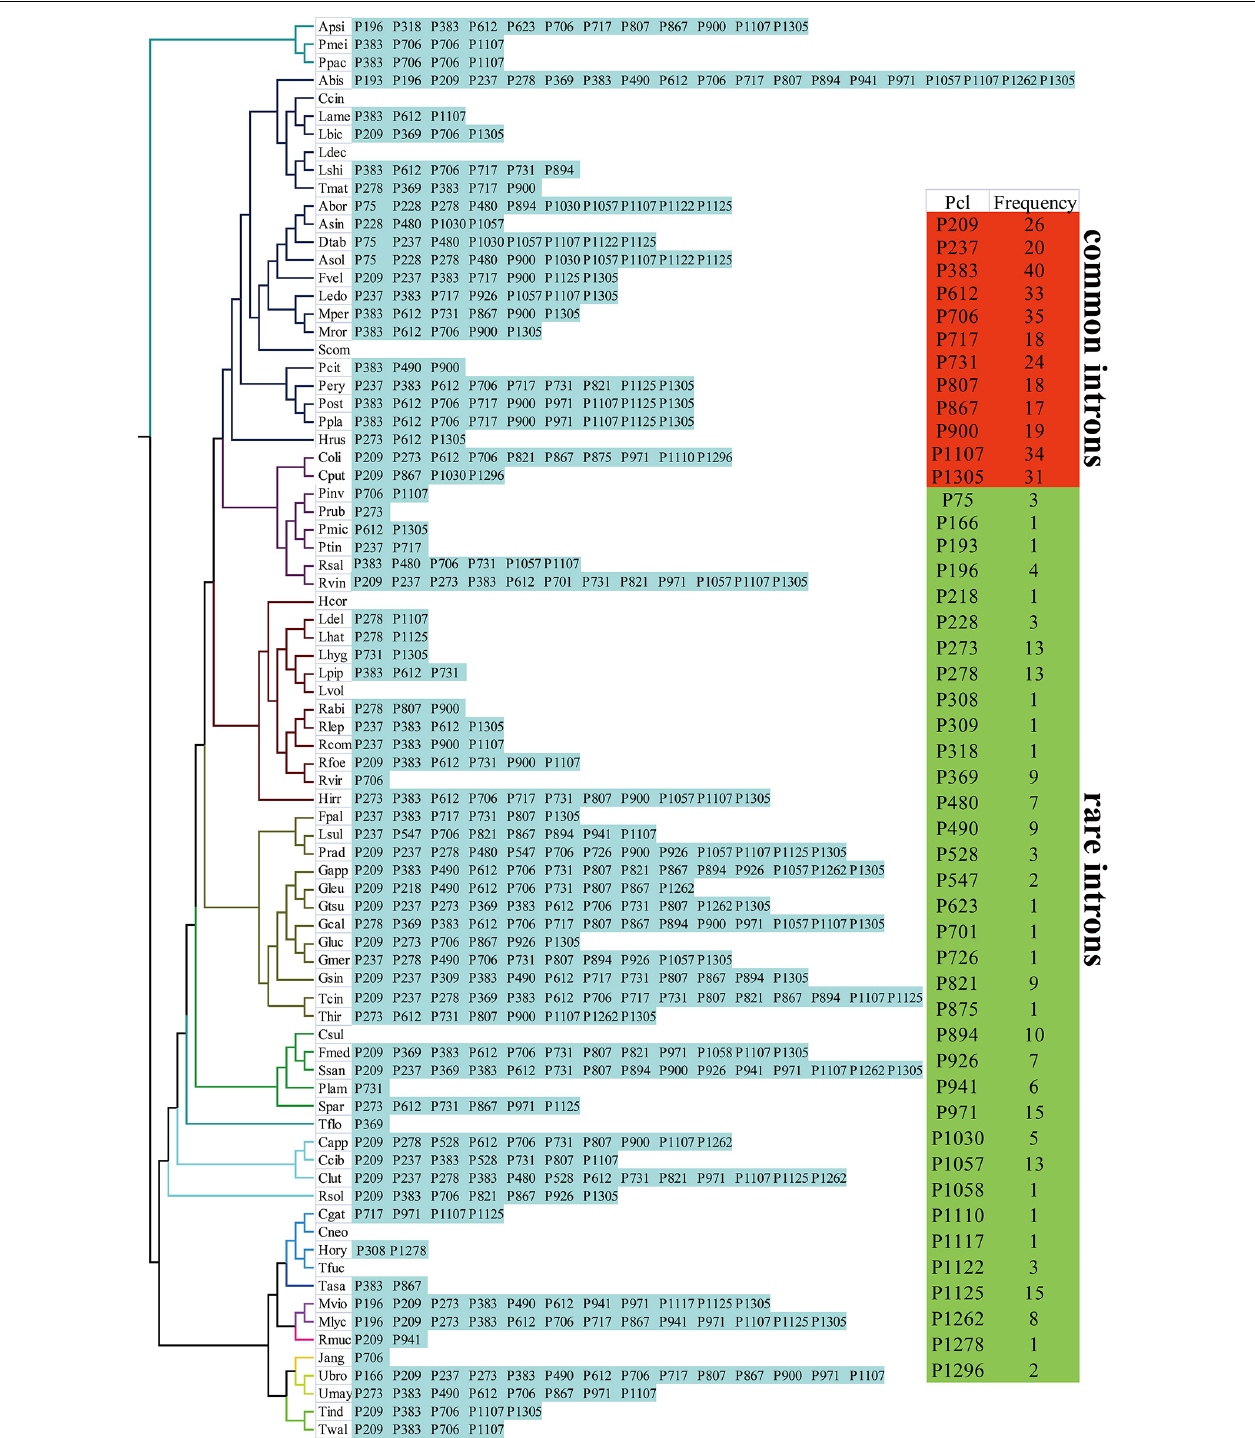
FIGURE 6 | Position class (Pcl) information of cox1 genes in the 79 Basidiomycota species. Introns in cox1 genes of 79 published Basidiomycota mitogenomes were classified into different position classes (Pcls) using the cox1 gene of G. calidophilum as the reference. Each Pcl was constituted by introns inserted at the same position of corresponding cox1 gene and named according to its insertion site in the aligned corresponding reference sequence (nt). The Pcls present in more than 1/5 of Basidiomycota species were considered as common Pcls in Basidiomycota, while introns detected in less than 1/5 of Basidiomycota species were considered to be rare introns. Phylogenetic positions of the 79 Basidiomycota species were established using the Bayesian inference (BI) method and Maximum Likelihood (ML) method based on concatenated mitochondrial genes. Species information is shown in Supplementary Table 6 .